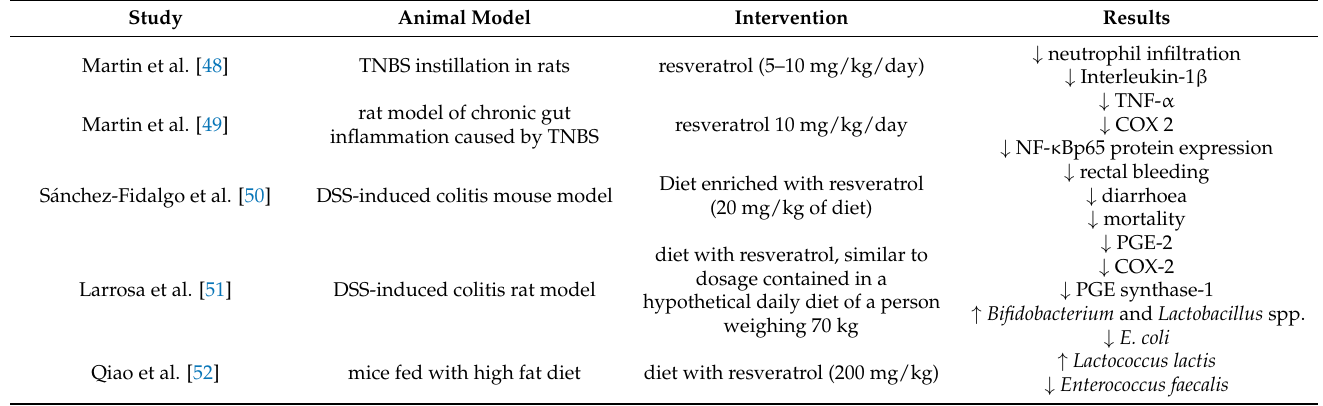
Table 2. Animal studies on wine polyphenols and